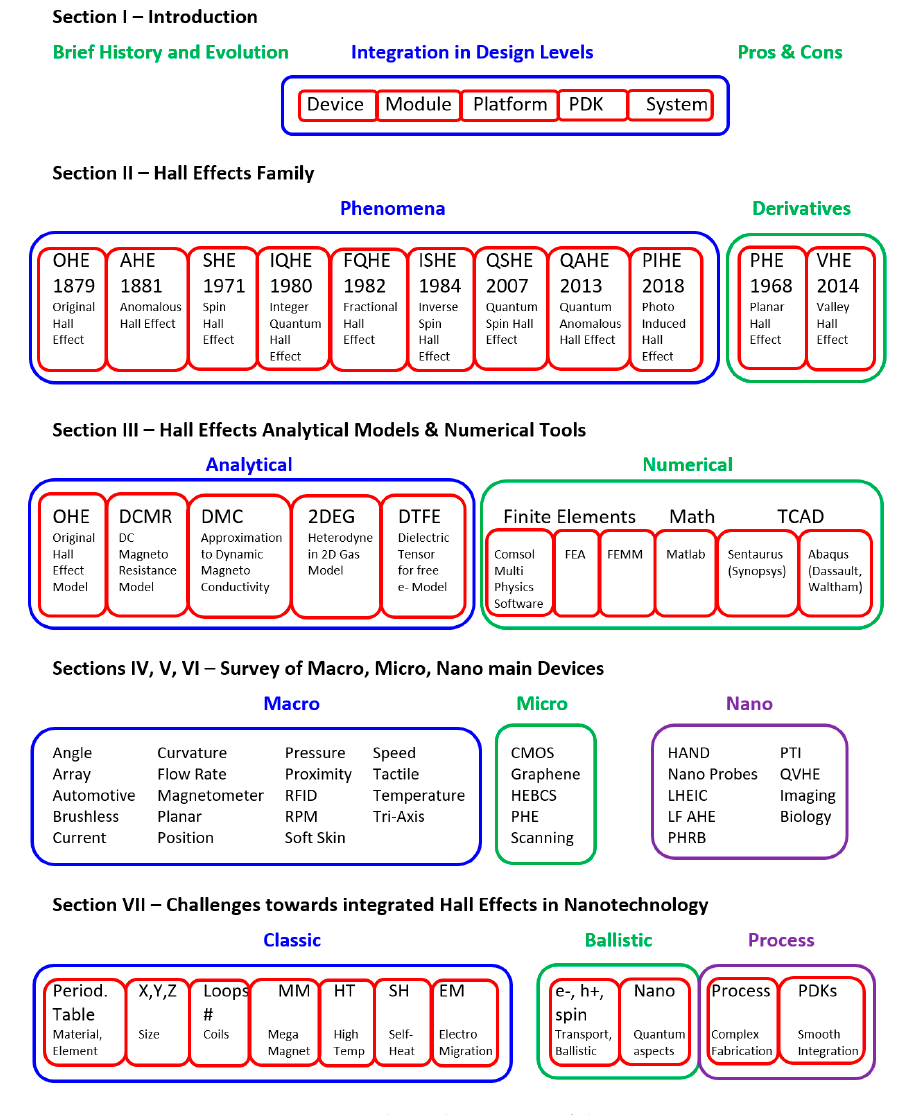
Figure A1. Condensed overview of this survey.